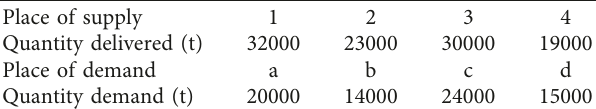
Table 2: Quantity of